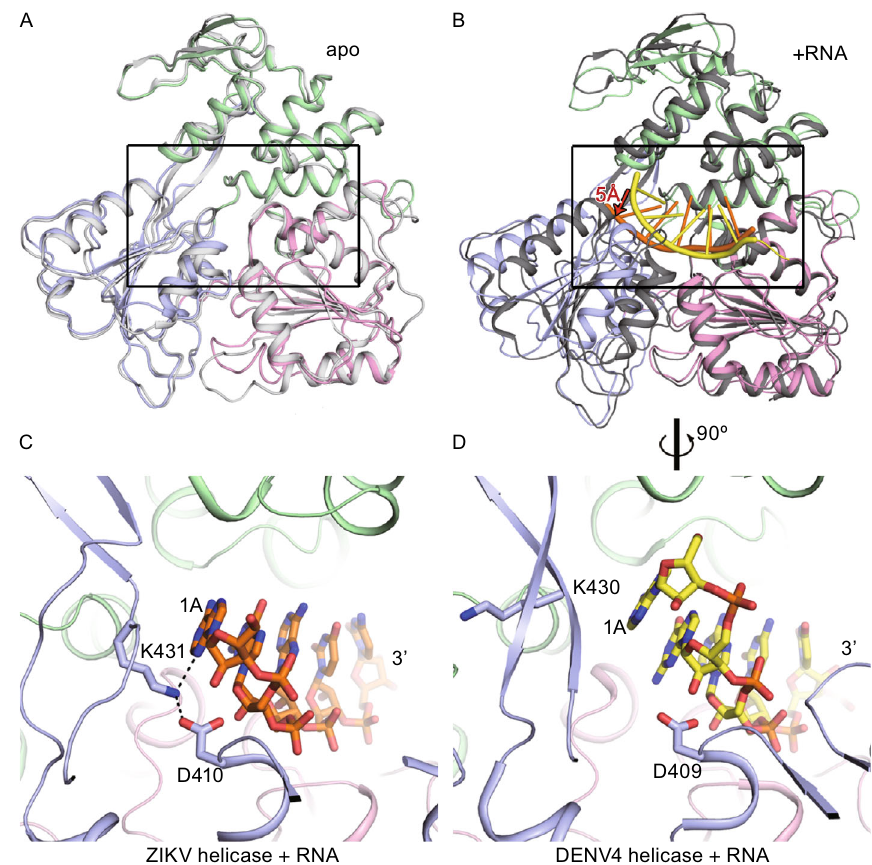
Figure 4. RNA recognition modes for ZIKV and DENV4 helicases. (A) Superposition of ZIKV (domains colored respectively) and DENV4 (white) apo-helicases. (B) Superposition of ZIKV (domains colored respectively and RNA in orange) and DENV4 (black and RNA in yellow) helicase-RNA complex. The distance between the sugar groups of nucleotide 1 in ZIKV and DENV4 helicases is marked in red. (C and D) show the conformation of subsite 1 of the ZIKV helicase-RNA complex (C) and the DENV4 helicase-RNA complex (D) in a 90° rotated view of (B). RNAs are shown in sticks and proteins are shown in ribbon with domains colored